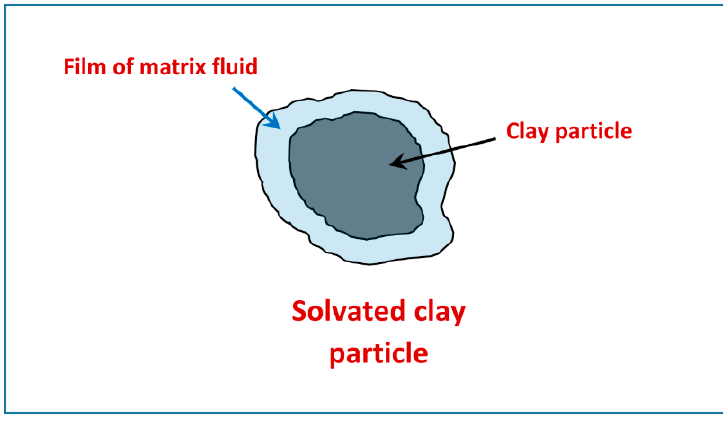
Figure 3. Nanoclay coated with immobilized dispersing aqueous film.